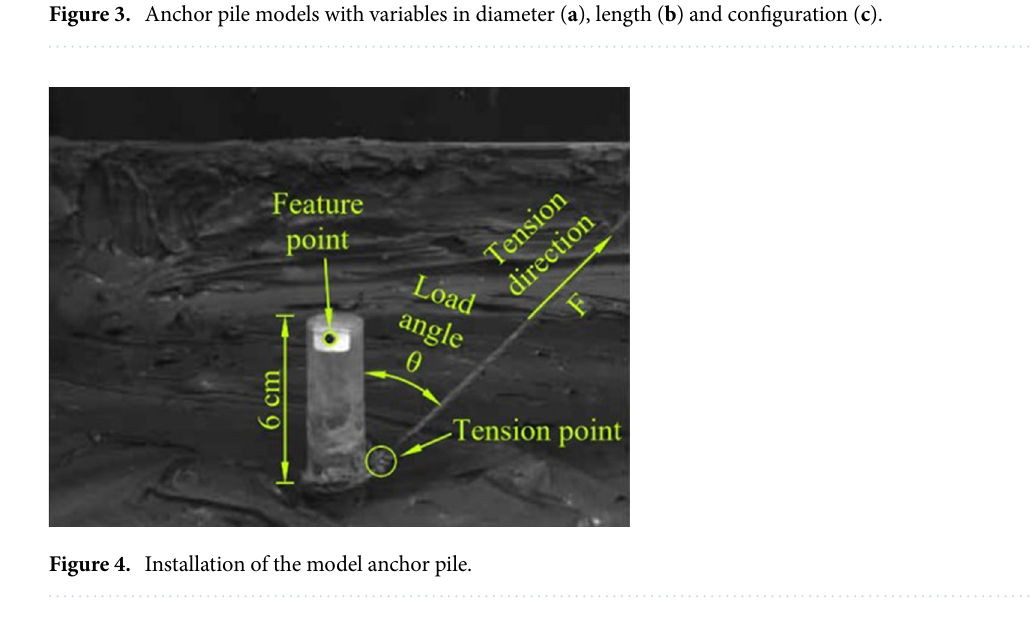
Figure 3. Anchor pile models with variables in diameter ( a ), length ( b ) and configuration ( c ).